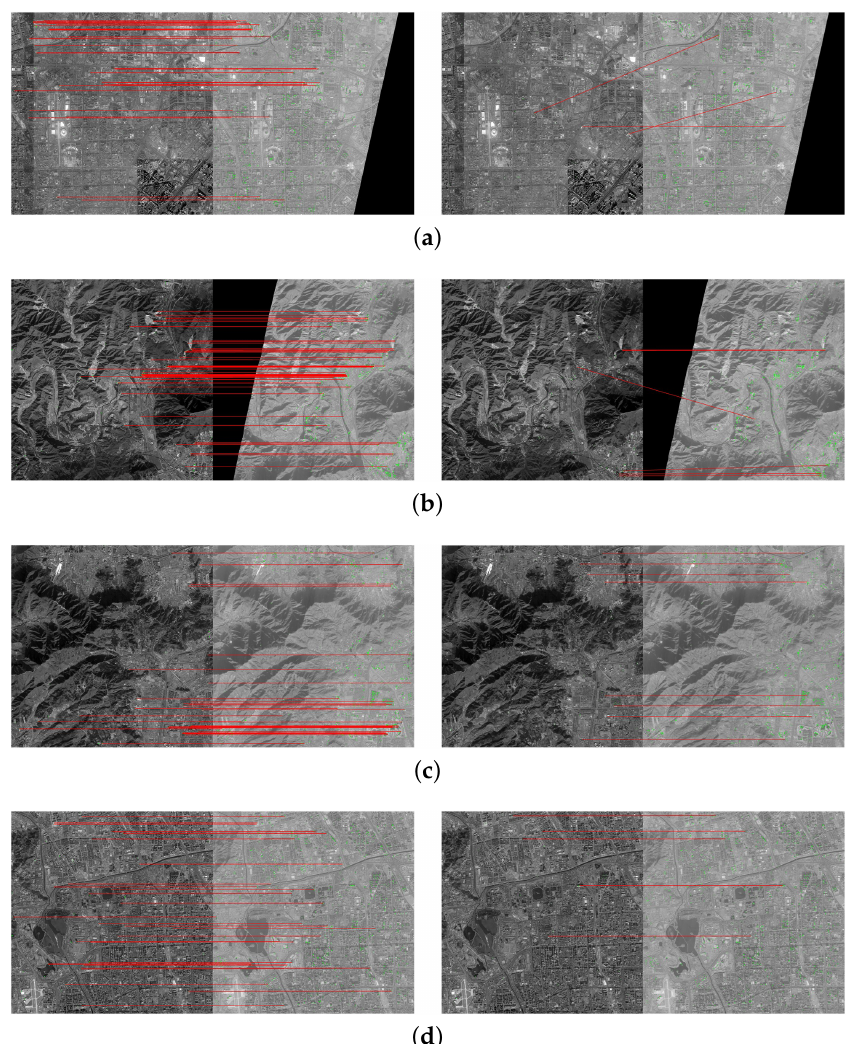
Figure 6. Comparison of the reference image matching method and the feature database matching method based on C -5. ( a – d ) C -5 image block matching. The left image is the result of matching with the feature database, and the right image is the result of matching with the reference image. The left end of each image connecting line is the reference image, and the right end is the test